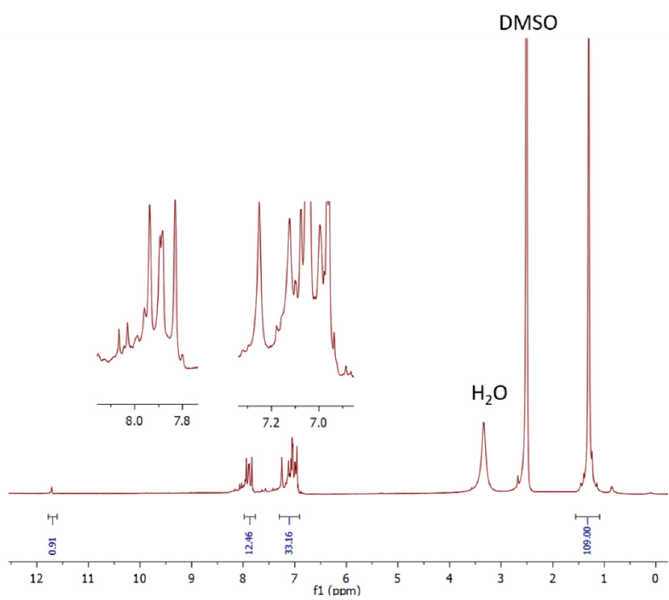
Figure 1. 1 H NMR spectrum for A 3 B tCzZnPc1 (in DMSO- d 6 ).